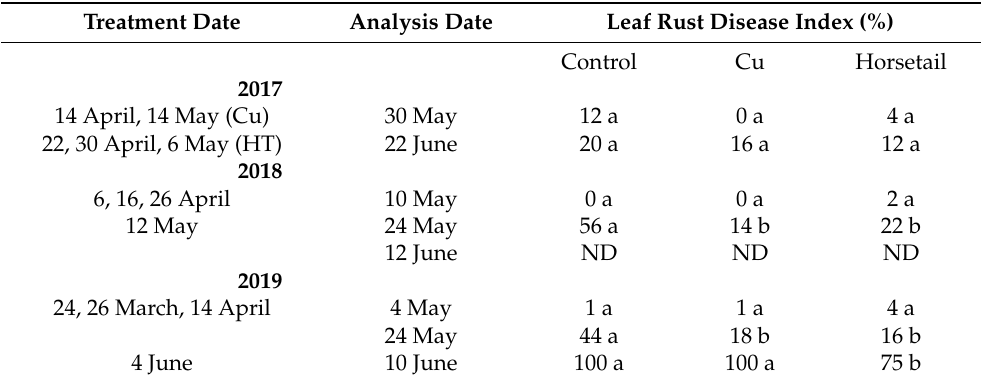
Table 2. Calendar dates for Cu and horsetail macerate treatments and disease ratings for Puccinia triticina (brown leaf rust) of durum wheat during routine analyses over a three-year period.